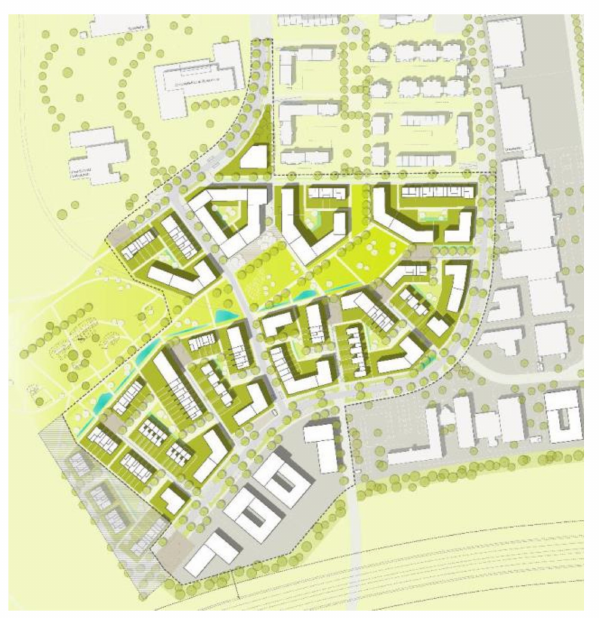
Figure 2. Site plan of the case study project (source: Ramboll Studio